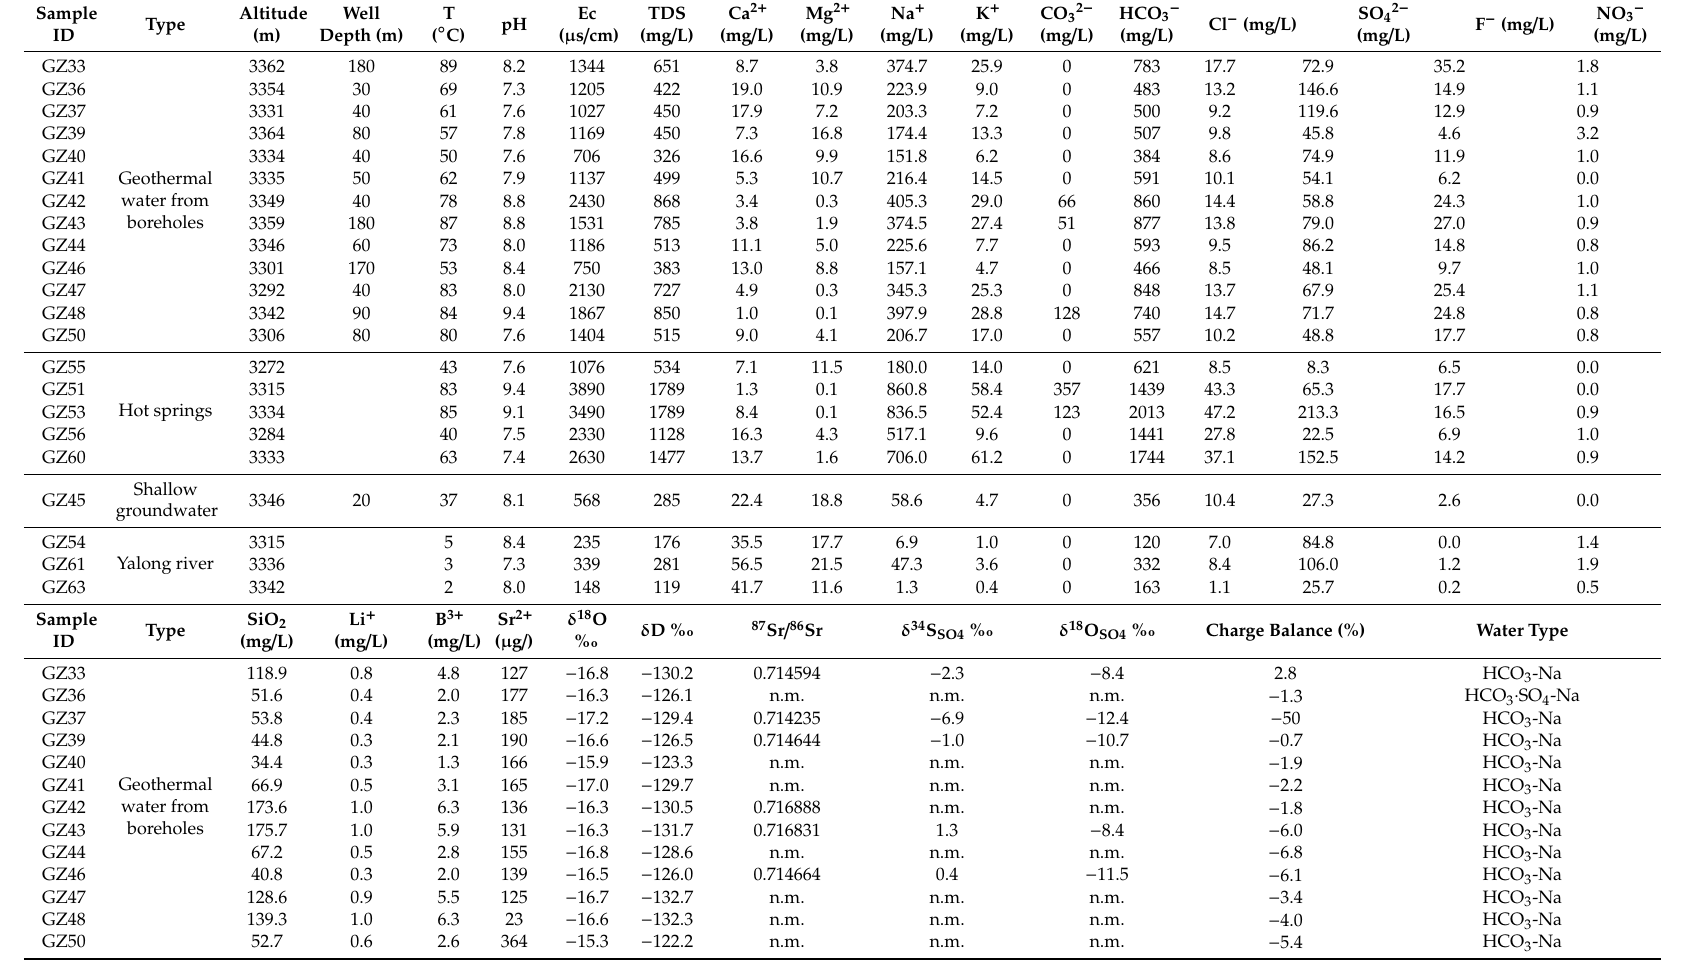
Table 1. Chemical and isotope composition of water samples (n.m. = not